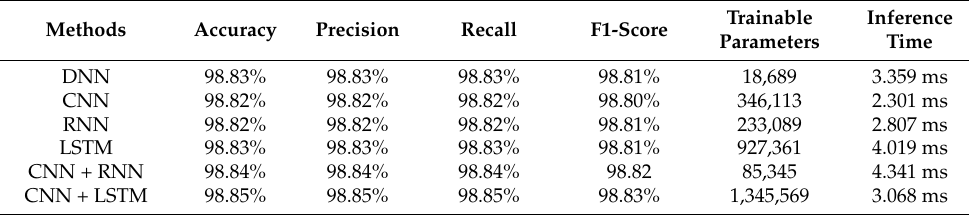
Table 29. Comparison results of binary